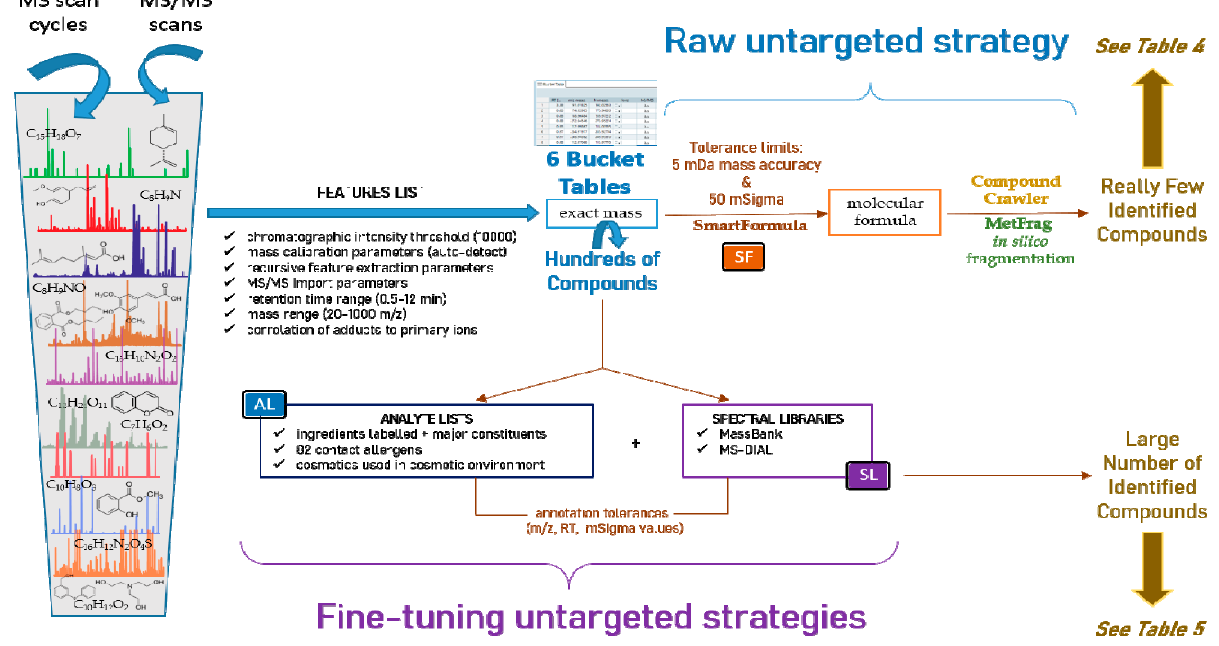
Figure 2. Scheme of post-processing untargeted routine combining raw and fine-tuning strategies. Table 4. Examples of proposed compounds putatively identified applying the raw untargeted